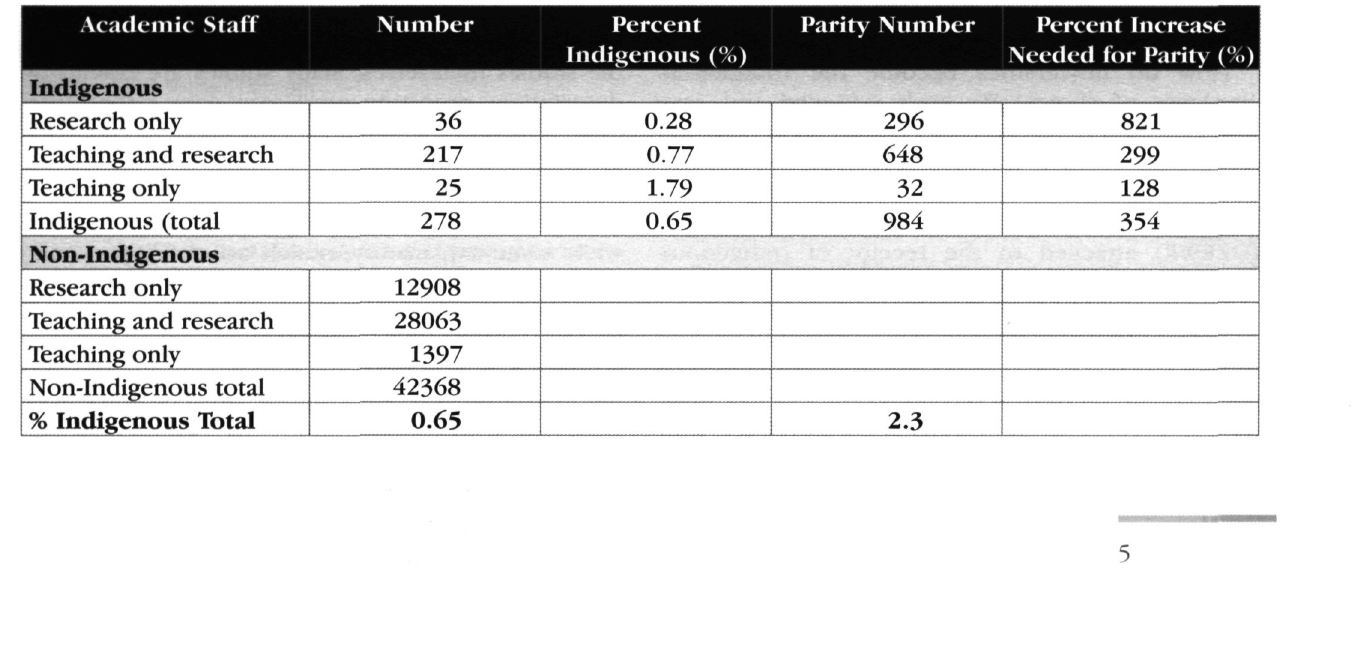
Table 2: Indigenous and non-Indigenous academic staff 2006. Figures represent numbers of staff in each function, not full-time equivalent staff (adapted from DEST, 2007a, 2007b; IHEAC,